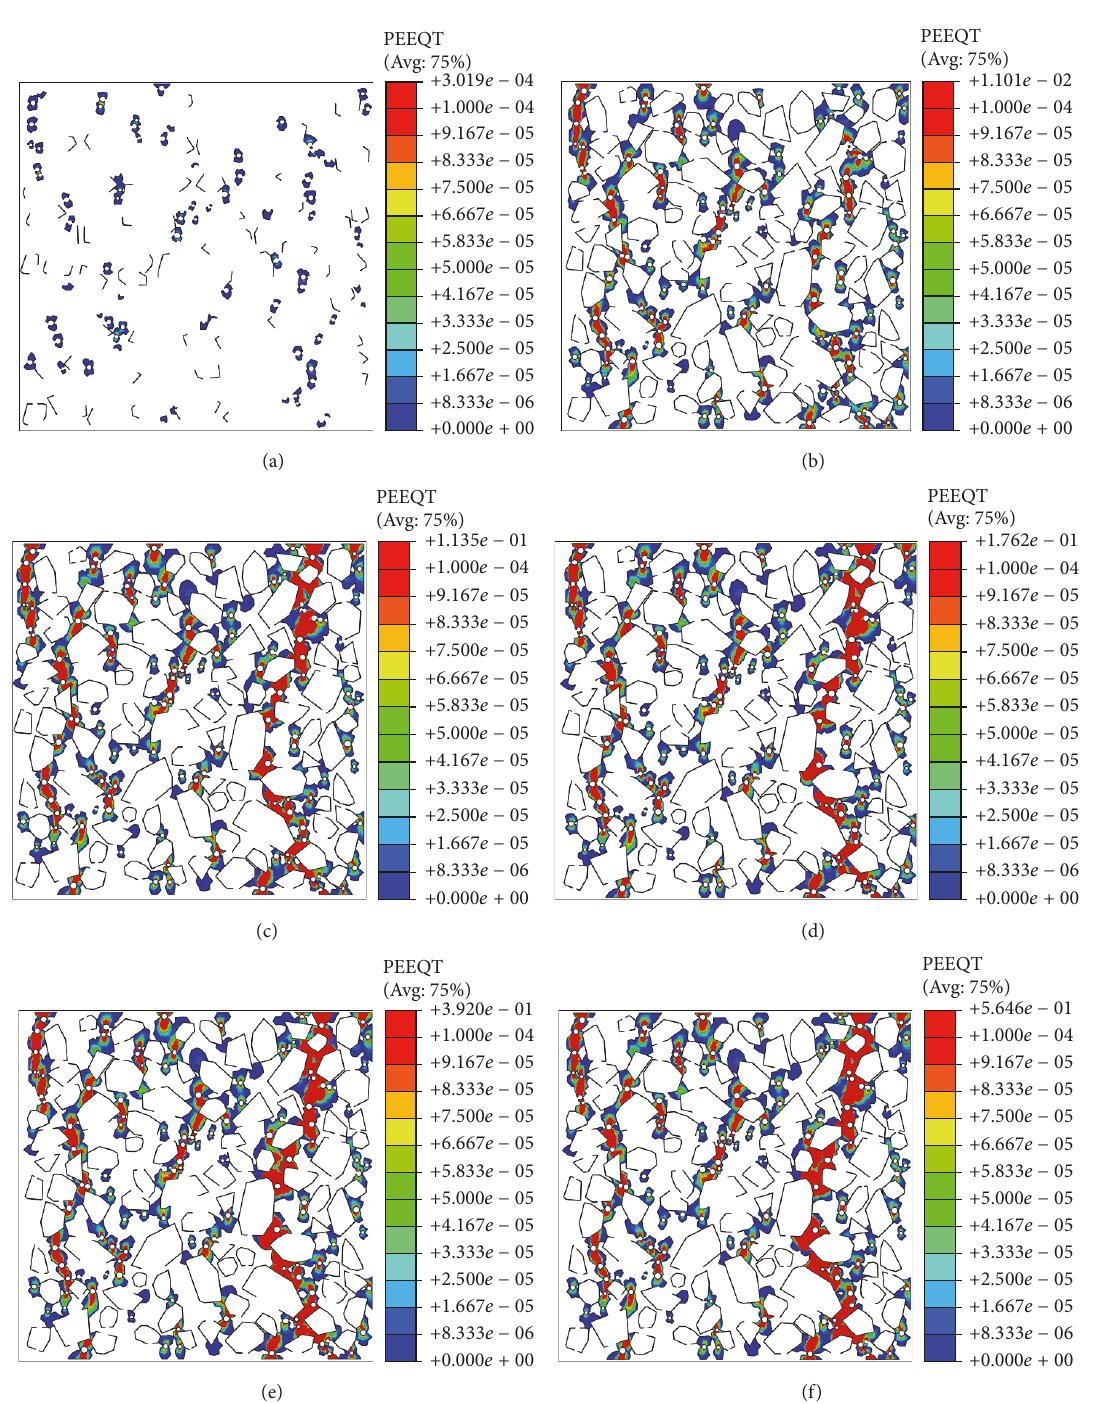
Figure 10: Mesoscale cracking development at different loading levels of concrete specimen with 𝐴 𝐹 = 40 % and 𝐴 V = 2 %. (a), (b), (c), (d), (e), and (f) show the equivalent tensile plastic strain distributions at points a–f, respectively.